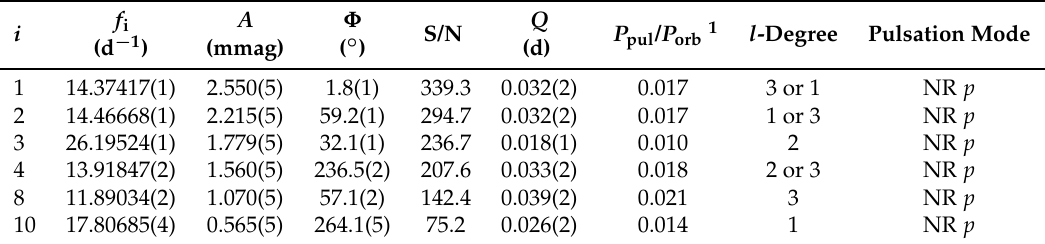
Figure 7. Representative example of Fourier fitting (solid line) on various data points for KIC 8504570. Table 2. Frequency search results and mode identification for the independent frequencies of the pulsating component of KIC 8504570. The errors are given in parentheses alongside values and correspond to the last